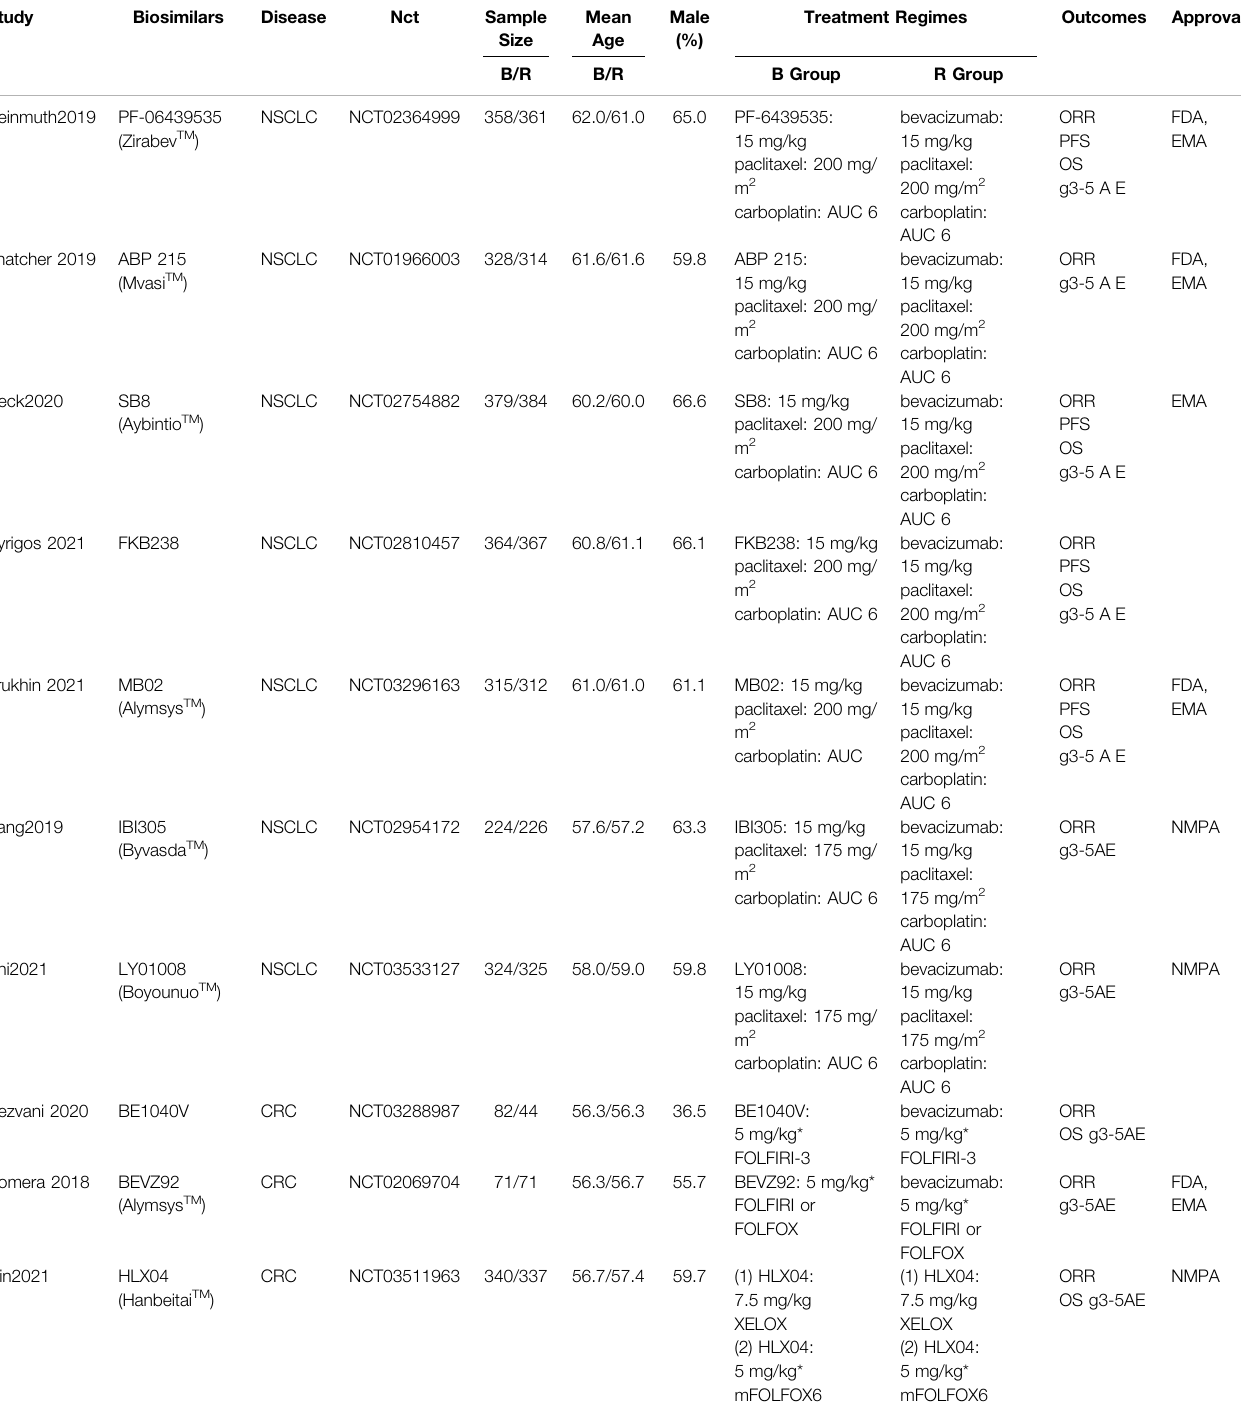
TABLE1 | Baseline characteristics of RCTs